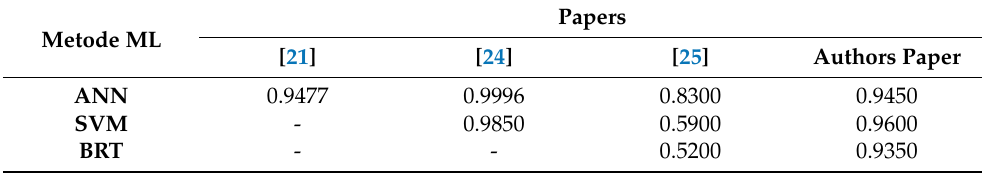
Table 6. Comparative analysis of R 2 data from the literature and this